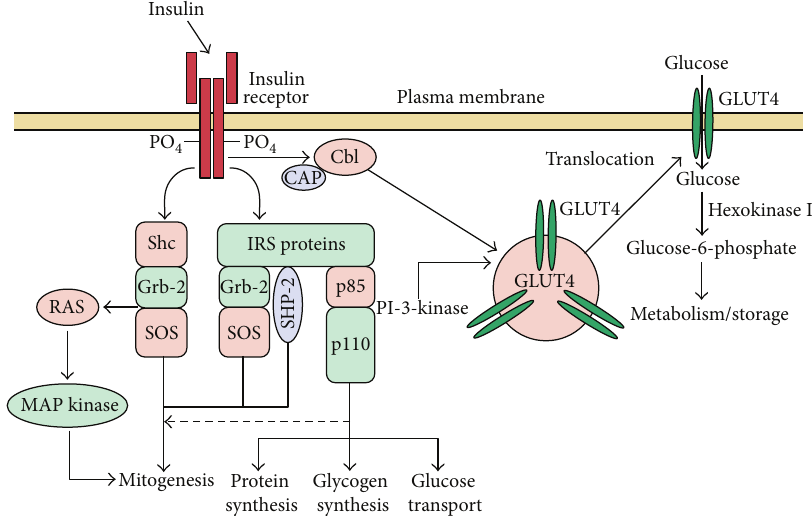
Figure 4: Insulin signal transduction pathway in skeletal muscle (adapted from